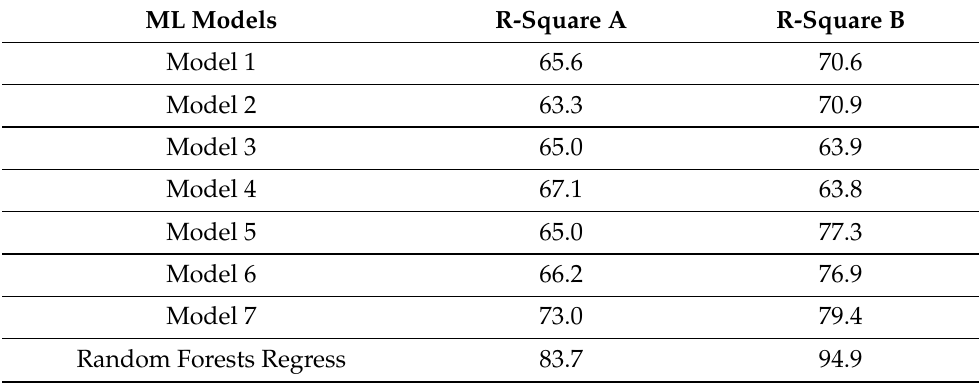
Table 5. Frequency bands prediction evaluation metrics using an alternative case